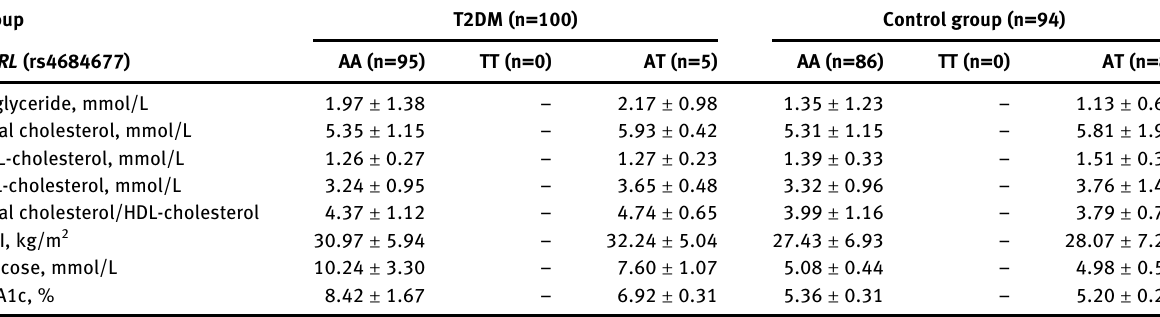
Table  : Distribution of the GHRL (rs  ) genotypes according to biochemical pro fi les in type  diabetes mellitus patient and control groups. Group